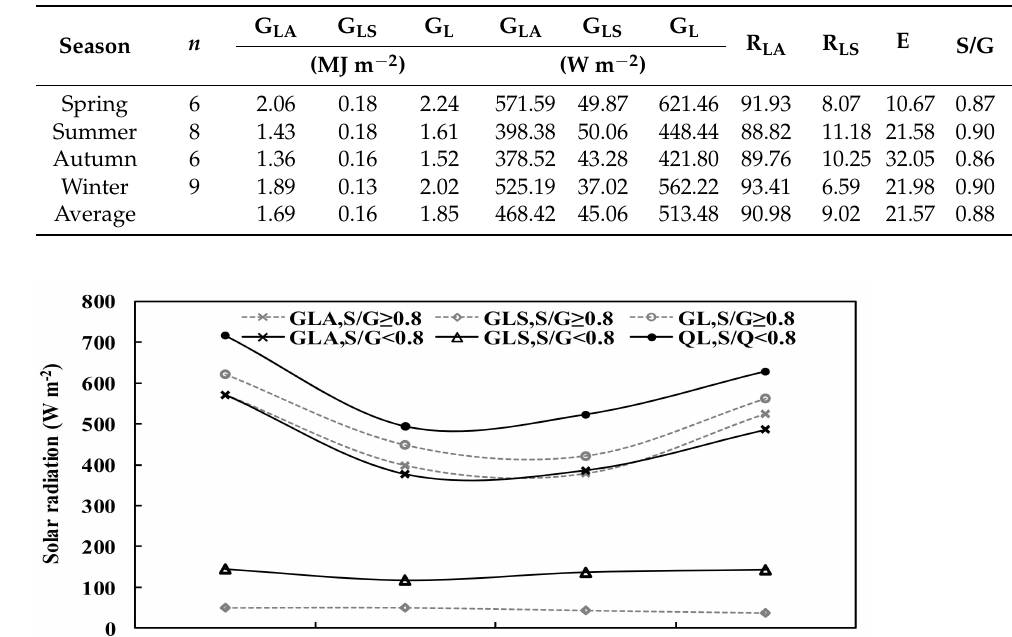
Table 3. Seasonal mean values of losses of global solar irradiance (MJ m − 2 ) and radiation (W m − 2 ) caused by absorbing and scattering substances (G LA and G LS ), total loss (G L = G LA + G LS ), and their contributions to total loss (R LA and R LS , %), seasonal mean values of monthly mean water vapor pressure (E, hPa), and S/G for S/G ≥ 0.8 conditions. n is the number of months in each season for which data are available.